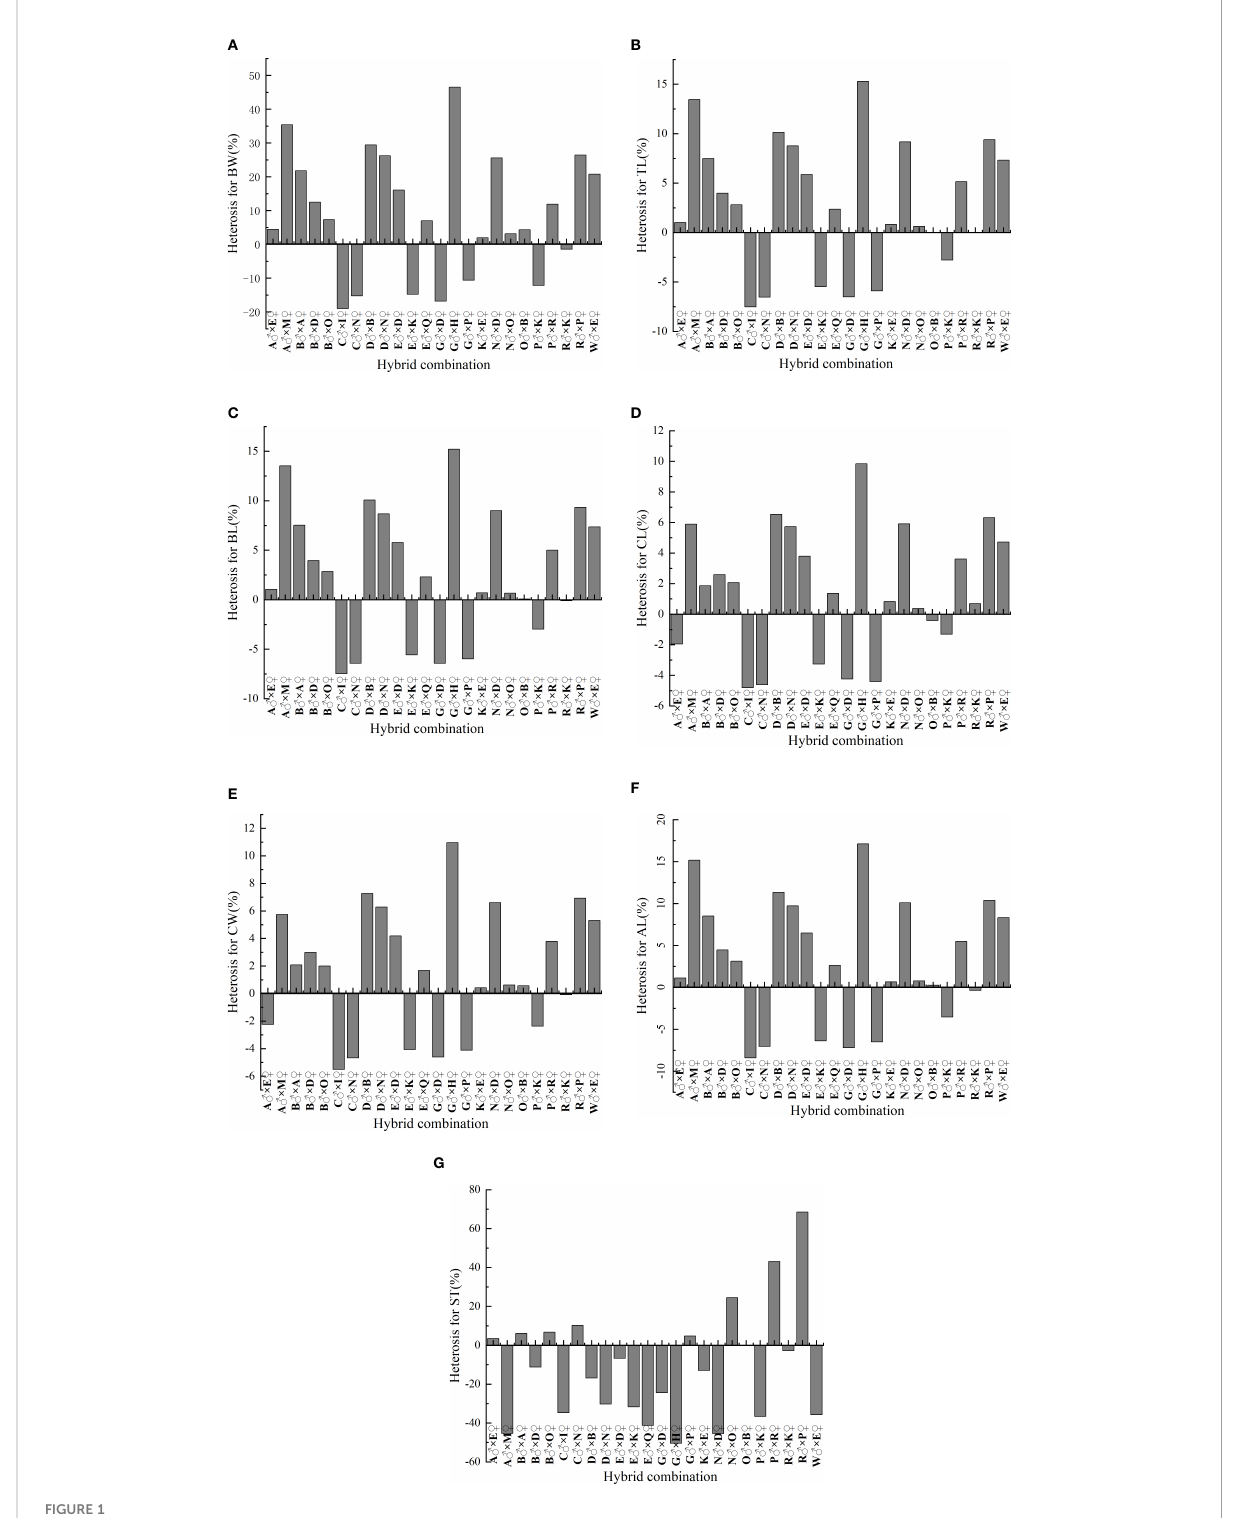
FIGURE 1 Heterosis in 24 hybrid combinations of L. vannamei. . (A) BW, body weight; (B) TL, total length; (C) BL, body length; (D) CL, carapace length; (E) CW, carapace width; (F) AL, abdomen length; (G) ST, survival